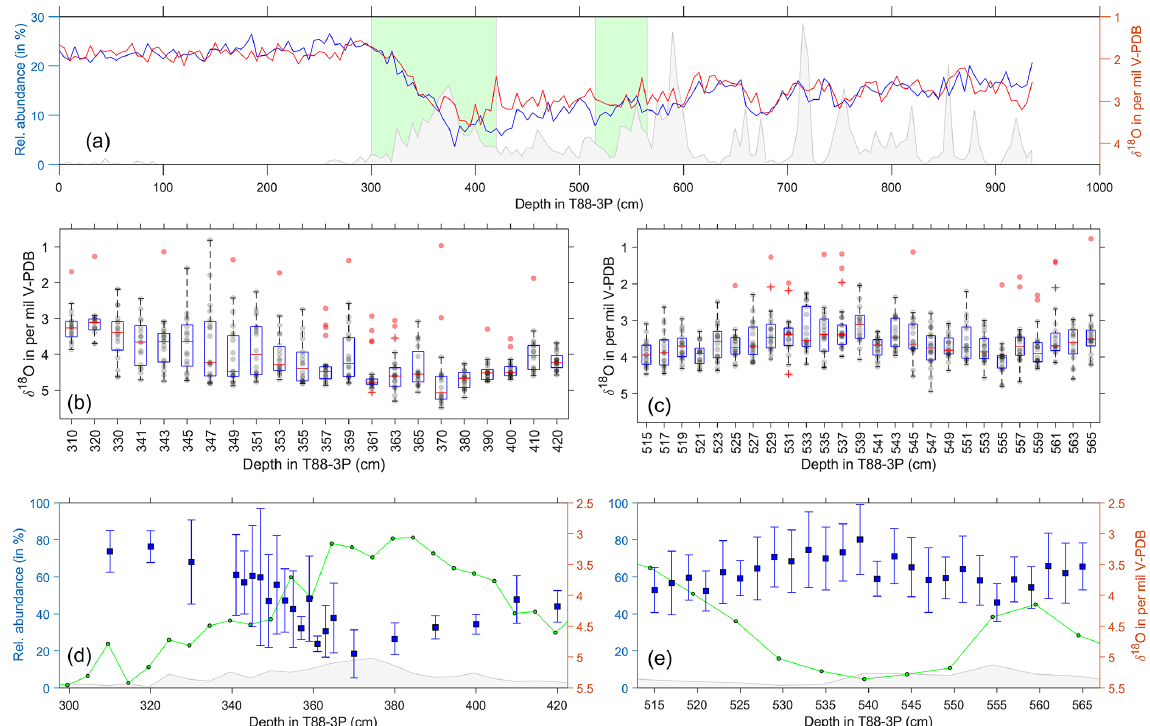
Figure 5. Single-foraminifera stable isotope data: N. pachyderma . (a) Pooled average oxygen stable isotopes of G. bulloides (blue) and G. glutinata (red), from Fig. 2, and ice-rafted debris (grey) for the same samples (Figs. 3 and 4). Green areas represent the deglacial ( b, d ) and glacial ( c, e ) samples. (b–c) Raw stable isotope values (grey) of N. pachyderma for each sample and the sample’s respective outliers (red). Overlain are the statistical features of the distribution outlined by a box-and-whisker plot (median, upper and lower quartiles). (d–e) Average values and the standard deviation (blue) of the outlier-corrected oxygen isotope data plotted alongside the abundance of N. pachyderma (green; see Fig. 4) and IRD (grey; see Fig.